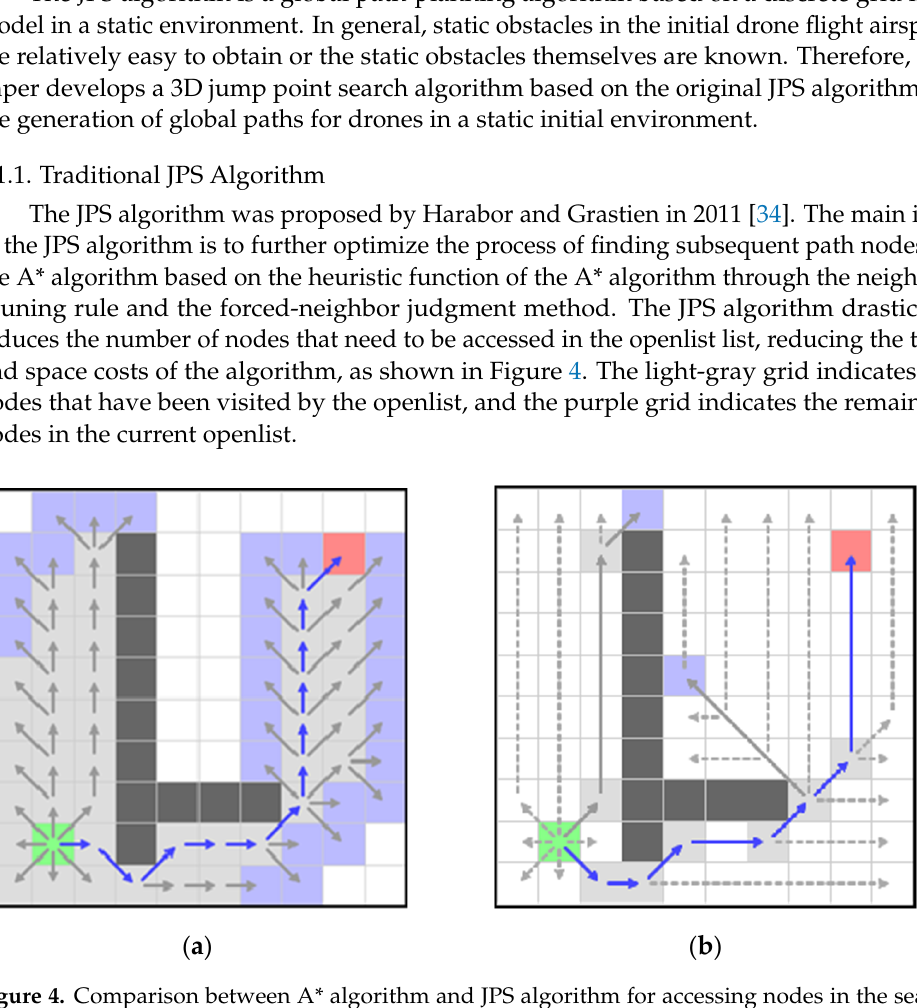
Figure 3. The working framework of this article.